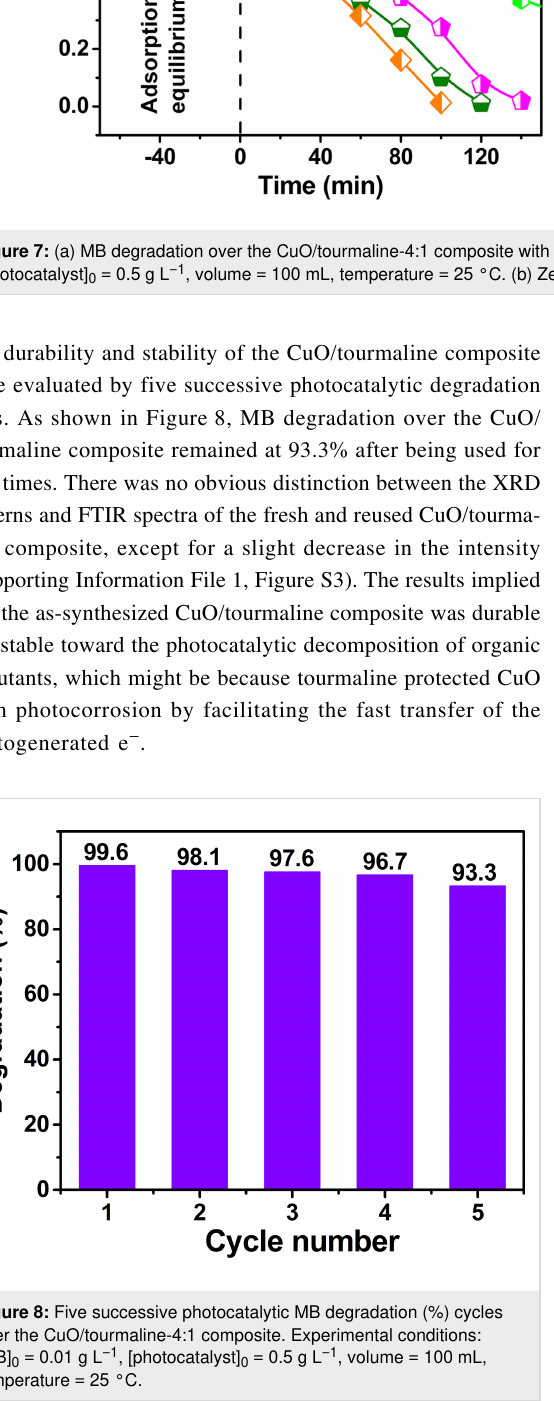
Figure 9: Schematic illustration of the role of tourmaline in enhancing the photocatalytic activity of CuO.